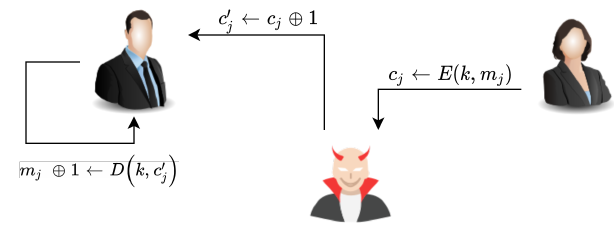
Figure 27. Overview of the malleability